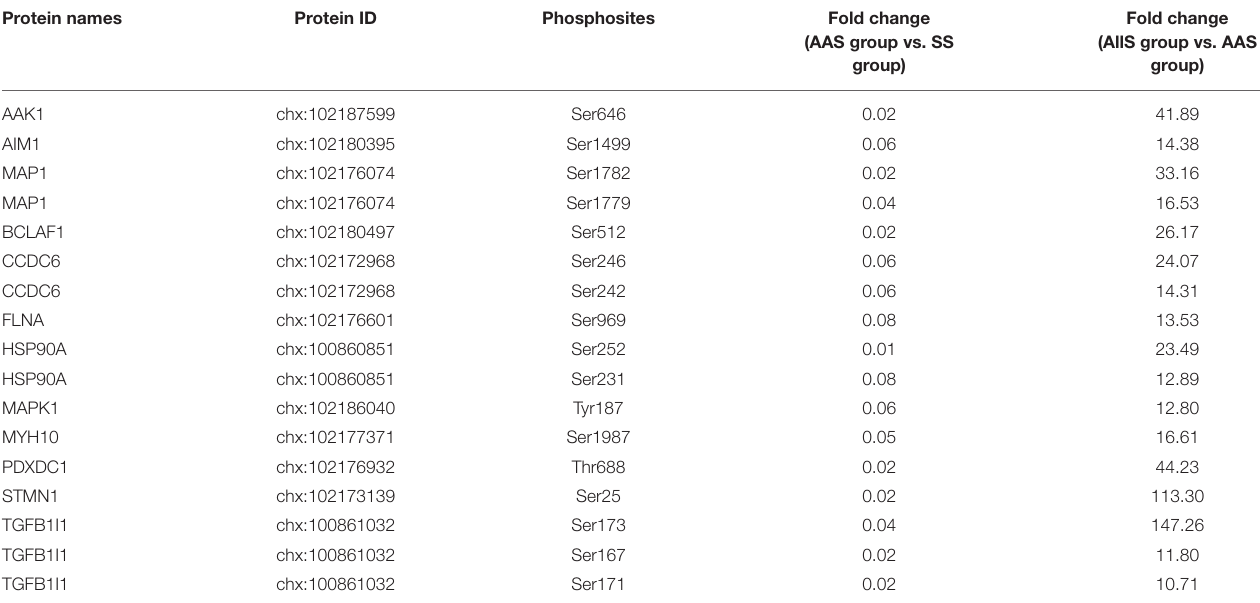
TABLE 4 | Relative quantitative data of phosphosites (|log 10 (FC)| > 1) responding to all amino acids signal. Protein